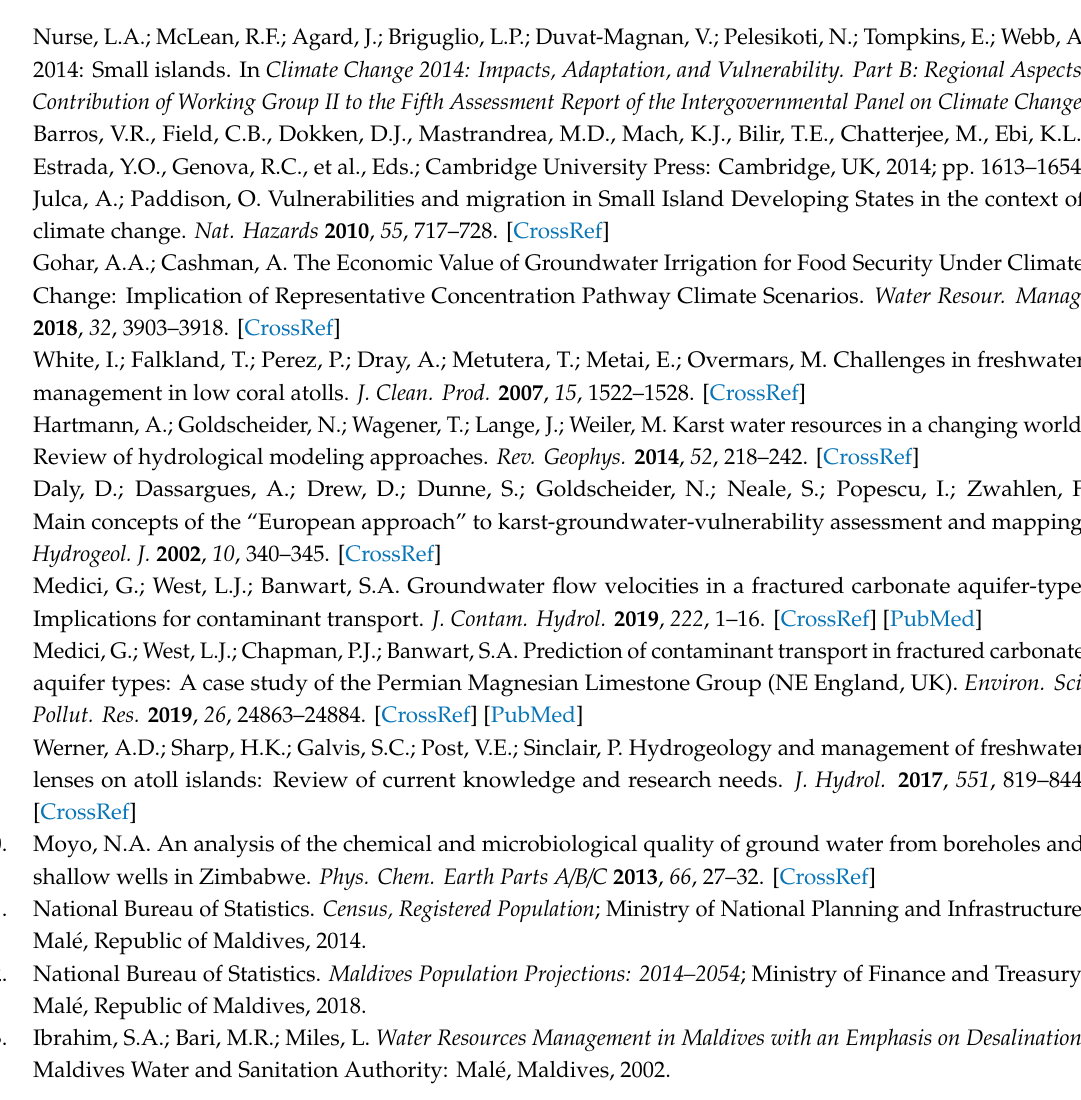
Figure S1: Distribution of water quality parameters., Figure S2: Water quality indicators in islands with > 5% using groundwater for cooking. Table S1: Definitions and links for statistical parameters used in the manuscript. Tables S2–S21: Results of correlation analyses. Table S22: Independent samples t -test